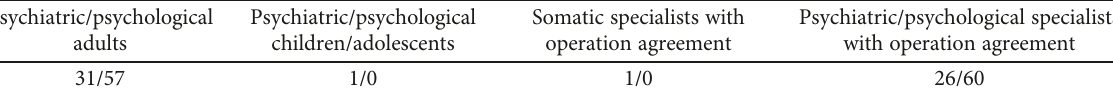
Table 2: Number of patients (female/male) with the diagnosis of F68.1 speci fi ed by health sectors.